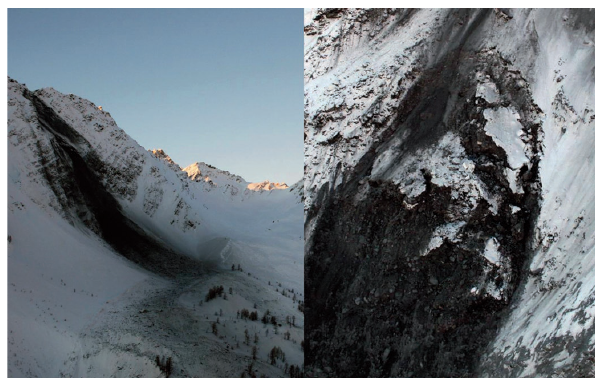
Fig. 7. North side of the Crammont (left) and detailed view (right) of the thick rock debris accumulation in the gentler bottom area of the rock-avalanche scar (13 January